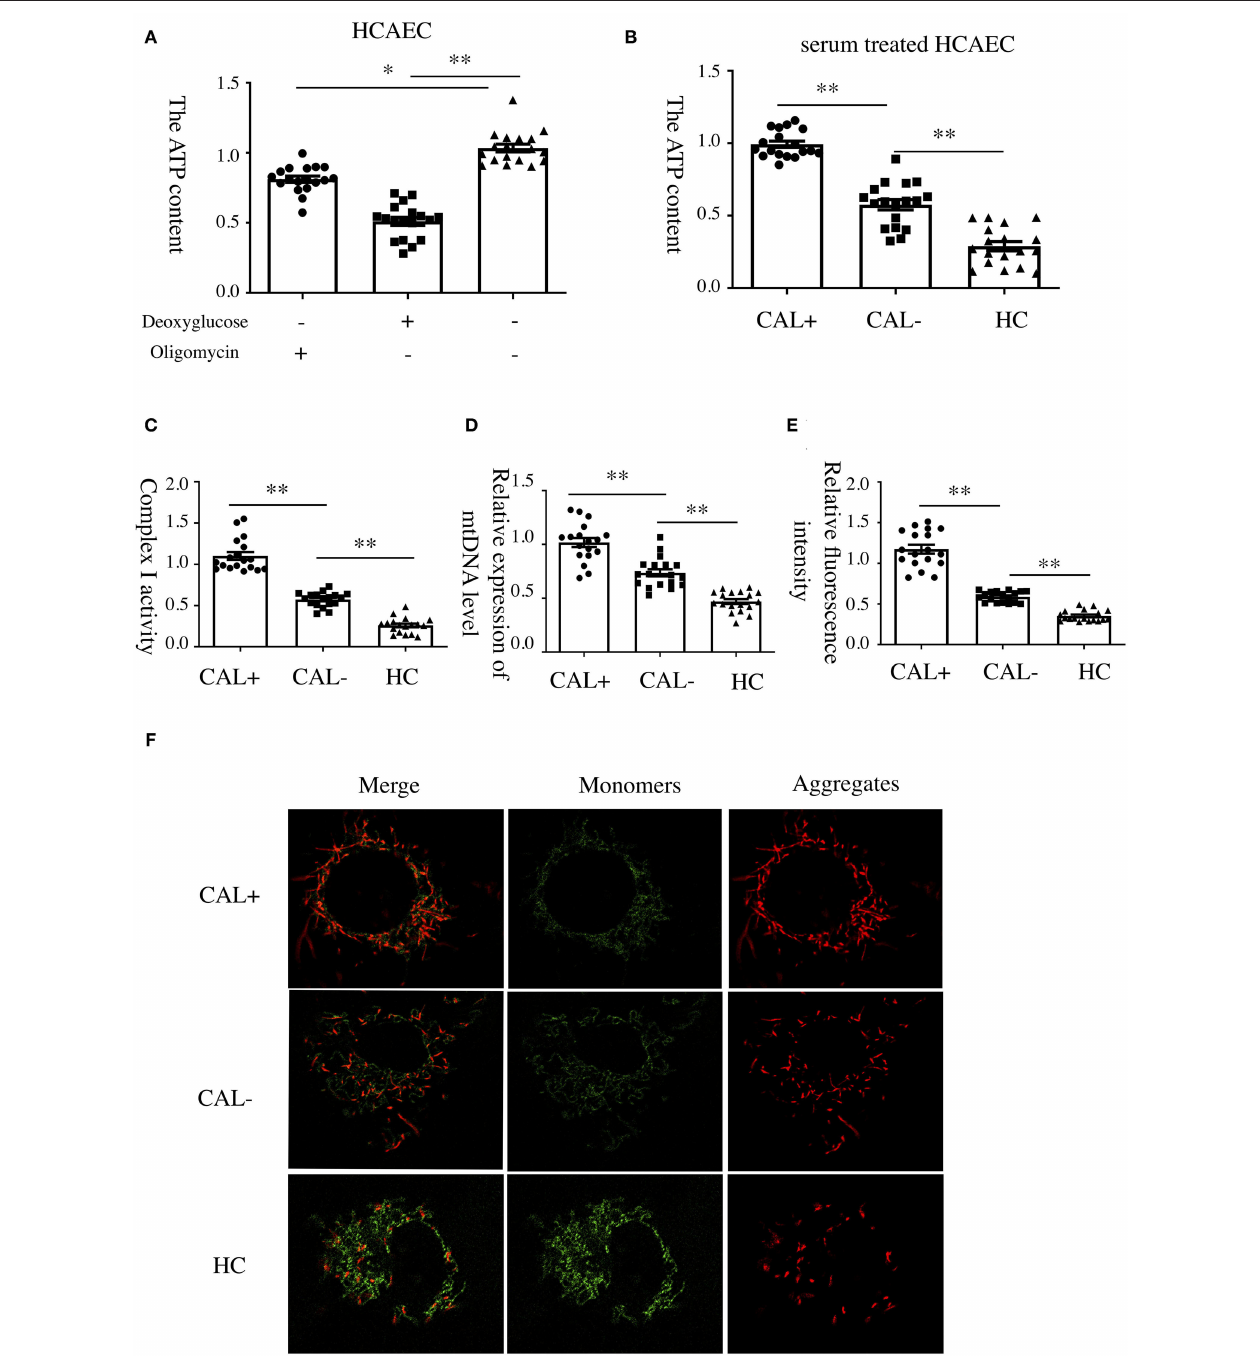
FIGURE 4 | Increased oxidative phosphorylation in Kawasaki disease with coronary artery lesion (KD-CAL + ) sera-treated human coronary artery endothelial cells (HCAECs). (A) HCAECs were treated with deoxyglucose (50 µ g/ml) and oligomycin (10mM) for 12h. Intracellular ATP content was determined by chemiluminescence apparatus. (B) HCAECs were treated with medium containing 15% sera from healthy controls (HCs; n = 6), Kawasaki disease without coronary artery lesion (KD-CAL–; n = 6), and KD-CAL + ( n = 6) for 4h. Intracellular ATP content was determined by chemiluminescence apparatus. (C) HCAECs were treated with medium containing 15% serum from HC ( n = 6), KD-CAL– ( n = 6), and KD-CAL + ( n = 6) for 4h. Mitochondrial Complex I activity was determined in 340nm with a microplate reader. (D) HCAECs were treated with medium containing 15% sera from HC ( n = 6), KD-CAL– ( n = 6), and KD-CAL + ( n = 6) for 4h. Mitochondrial gene copy number was measured by qPCR. (E,F) HCAECs were treated with medium containing 15% sera from HC ( n = 6), KD-CAL– ( n = 6), and KD-CAL + ( n = 6) for 4h. Mitochondrial membrane potential was determined by JC-1 (monomers green, aggregates red) analyzed by confocal microscopy. (F) Statistical analysis of relative fluorescence intensity (red/green). All samples were normalized to HCAECs with CAL serum treatment or control. The bar graphs are mean ± SEM. * P < 0.05 and ** P < 0.01 compared with the indicated group.